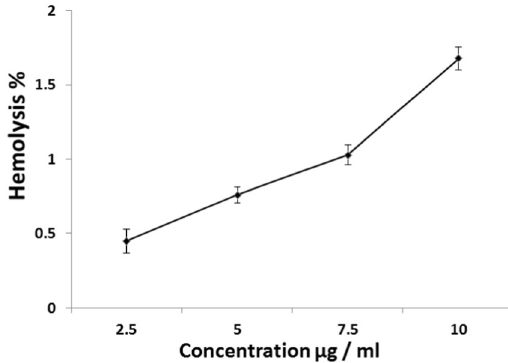
Figure 9. Percentage of hemolysis caused by